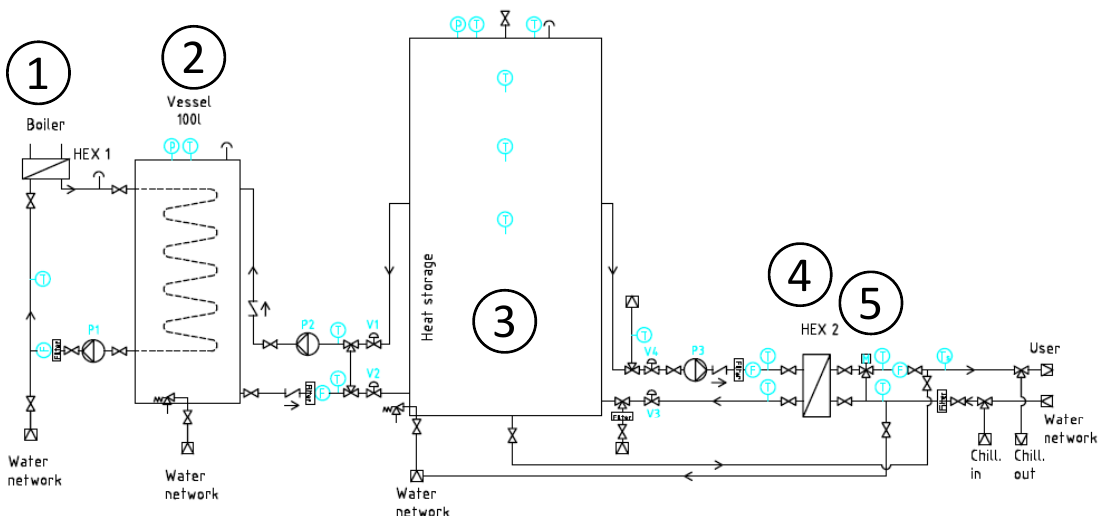
Figure 2. Hydraulic schematic of the TES test rig at ITAE lab: 1, electric boiler high-temperature heat source; 2, intermediate buffer; 3, TES system under examination; 4, intermediate HEX on the energy withdrawal side; 5, automatic mixing valve.